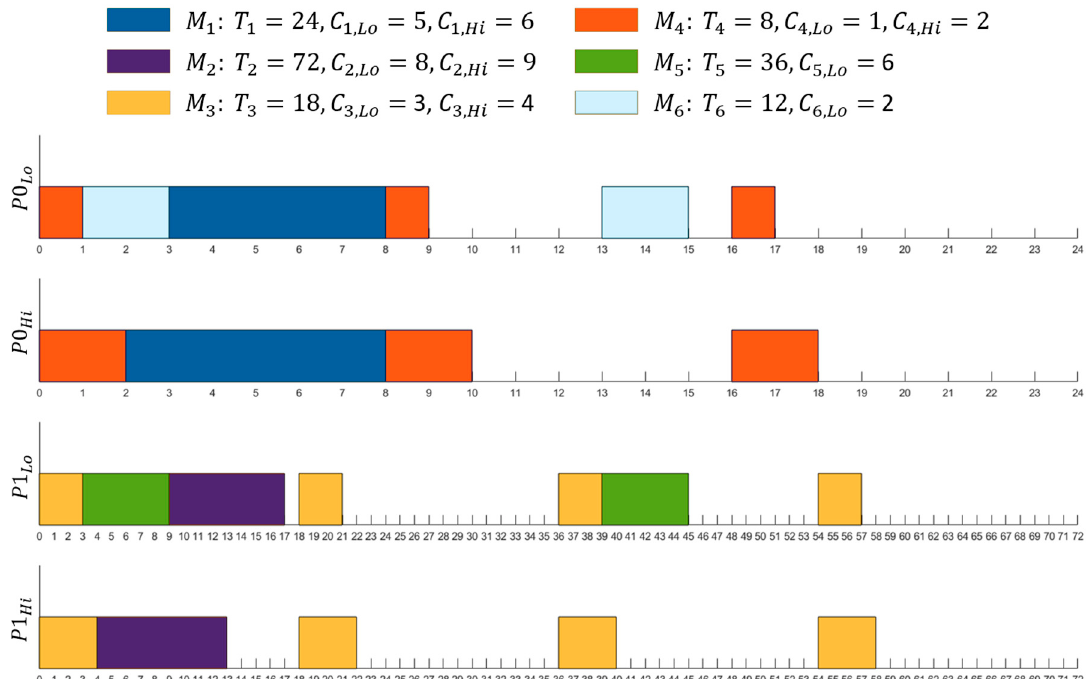
Figure 5. Partitioned Fixed Execution Non-Preemptive Mixed Criticality (P_FENP_MC) scheduling of the six-task set example.